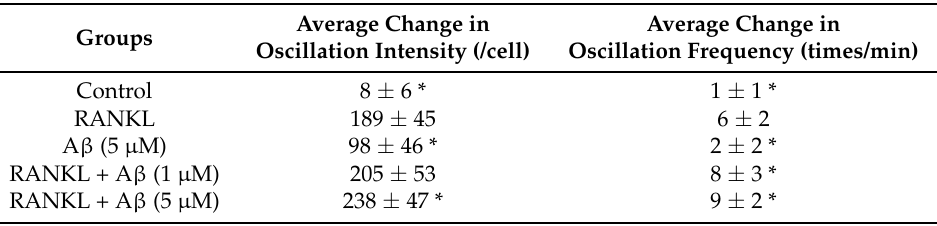
Table 1. A β 42 increases RANKL-induced calcium